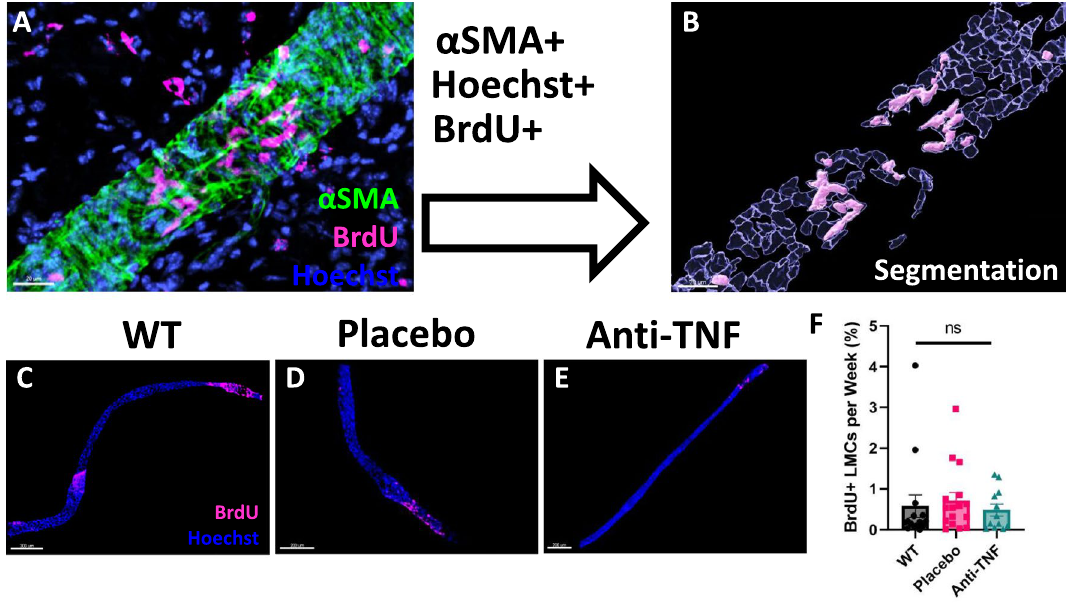
Figure 4. WT and TNF-Tg PLV-LMCs exhibit limited and unchanged turnover by 8-months of age. Along with the placebo and anti-TNF treatments, BrdU was administered daily for 6-consecutive weeks to evaluate LMC turnover during the treatment period. Following the 6-week period, PLVs from WT and TNF-Tg mice were harvested and immunostained for αSMA (green) and BrdU (pink) with a Hoechst nuclear dye (blue). For cellular colocalization analysis, confocal stacks across the entire length and depth of the whole-mounted PLVs were collected. Imaris software was used to visualize total Hoechst + and Hoechst + /BrdU + nuclei masked within αSMA + LMCs with a high-magnification image of an anti-TNF treated TNF-Tg PLV provided as a representative image (A) . The nuclei were then segmented as individual cells to quantify total Hoechst + LMC nuclei (transparent blue objects) and Hoechst + /BrdU + LMC nuclei (solid light pink objects) that contributed to the vessel during the treatment period (B) . Representative low-magnification images of WT (C) and TNF-Tg PLVs treated with placebo (D) or anti-TNF (E) therapy are shown with no significant difference in the proportion of αSMA + /BrdU + LMCs per week (F) . Statistics: One-way ANOVA with Tukey’s multiple comparisons; no significance (ns), p > 0.05 . Sample size: Each datapoint represents an individual PLV from WT (n = 4 mice, n = 15 PLVs), TNF-Tg placebo (n = 4 mice, n = 16 PLVs), and TNF-Tg anti-TNF (n = 3 mice, n = 12 PLVs) cohorts. All data is presented as mean ±